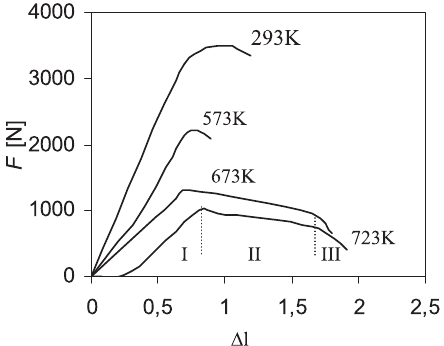
Fig. 11: Comparison of real F- D l curves of the composite materials